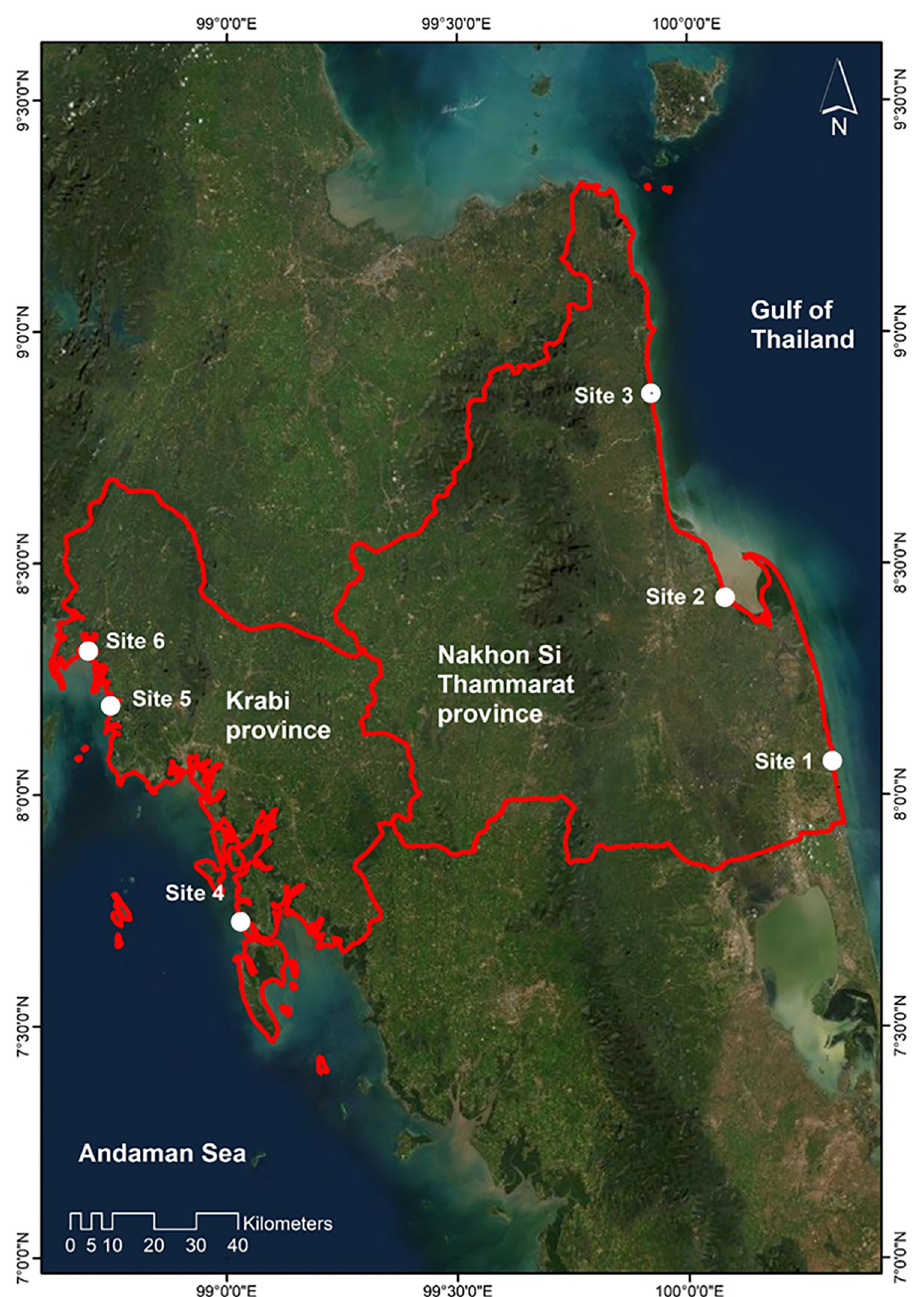
Fig 5. Sites selected for more detailed evaluation of processes influencing coastal dynamics. Basemap satellite images accessed from World Imagery ESRI Tile Layer. Credits: Esri, Maxar, GeoEye, Earthstar Geographics, CNES/ Airbus DS, USDA, USGS, AeroGRID, IGN, and the GIS User Community. https://doi.org/10.1371/journal.pone.0272977.g005 Site 3 : A natural sandy beach showing net erosion (Fig 8). This site is located in the sedimentary sub-cell just updrift of the Hin river; more explicitly it is about 5 km South from the Hin river mouth and exhibits net erosion between May 1996 and Feb 2018 measured at -2.3 m/y. From May 1996 to May 2003, the shoreline moved